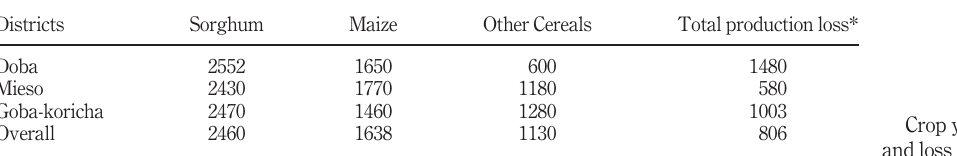
Table IV. Crop yield